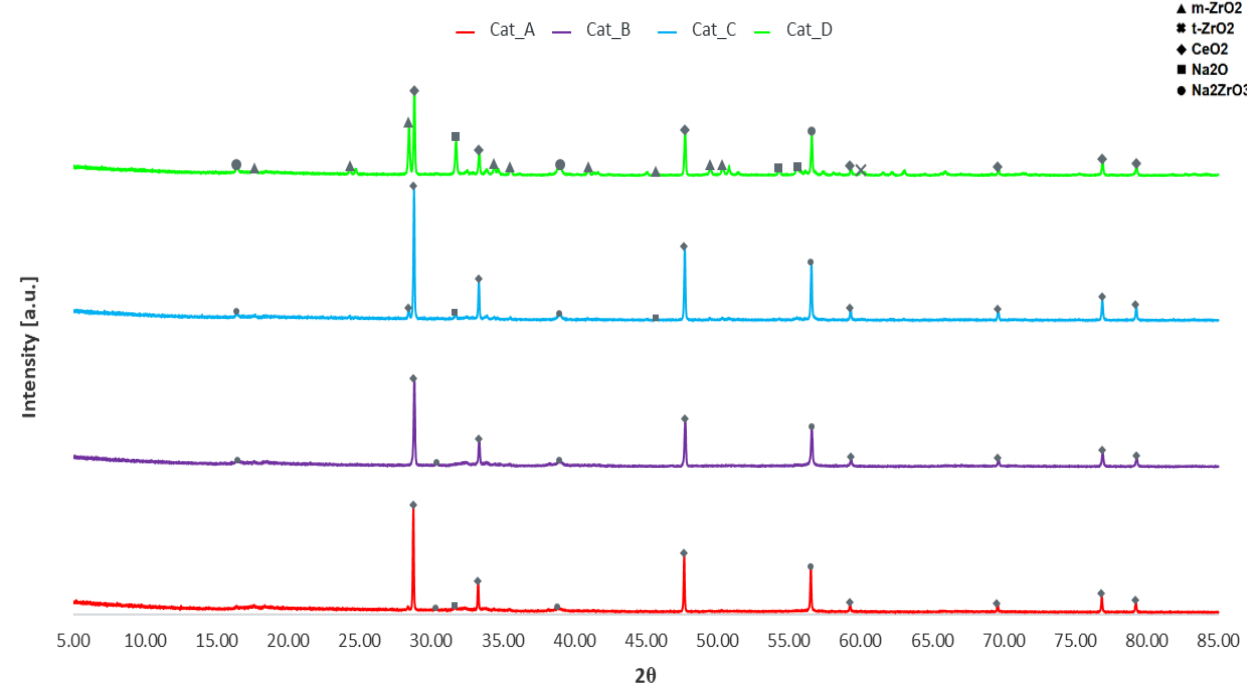
Figure 1. XRD patterns of Catalytic Mixtures A–D.